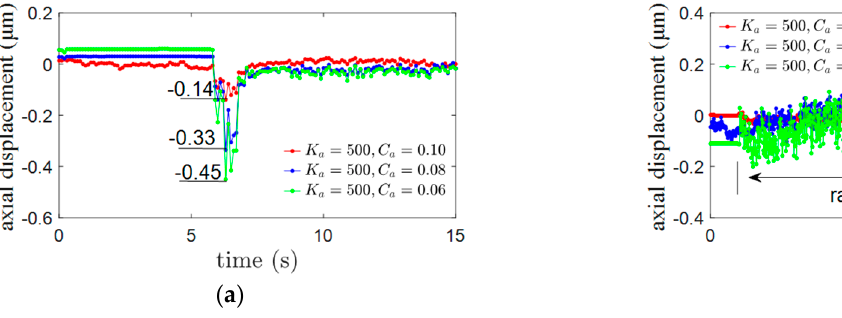
Figure 9. The translational displacements of the 5 − DoF MSMW with different types of disturbances. ( a ) The axial translational displacements of the flywheel rotor suffering the impulse disturbance with different damping coefficients. ( b ) The axial translational displacements of the flywheel rotor suffering the random disturbance with different damping coefficients.